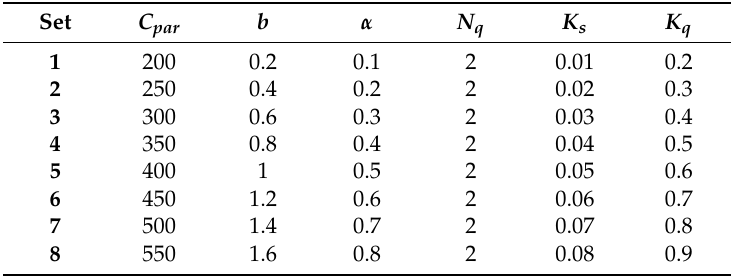
Table 2. Initial parameter sets used in the DSM